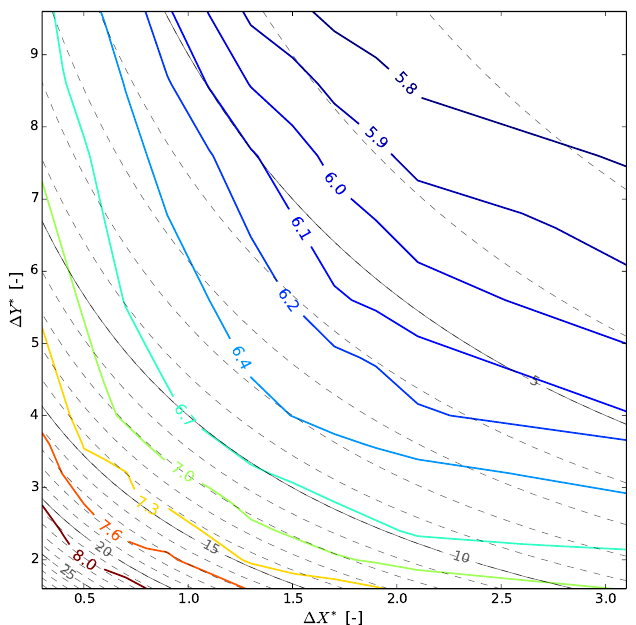
Figure 6. Isolines for the thermal resistance for the central heat source (colored lines) compared to the heat source density (grey lines) as functions of horizontal and vertical